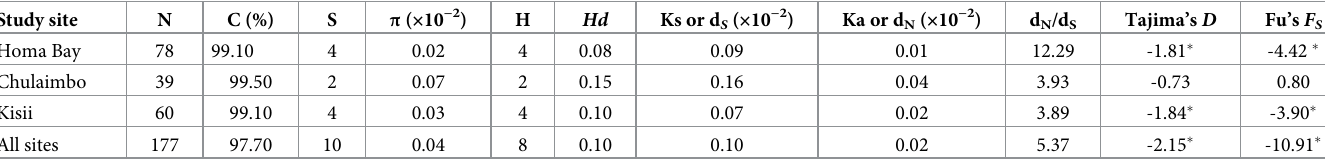
Table 2. Summary of genetic diversity indices of Pfs25 gene in western Kenya. Study